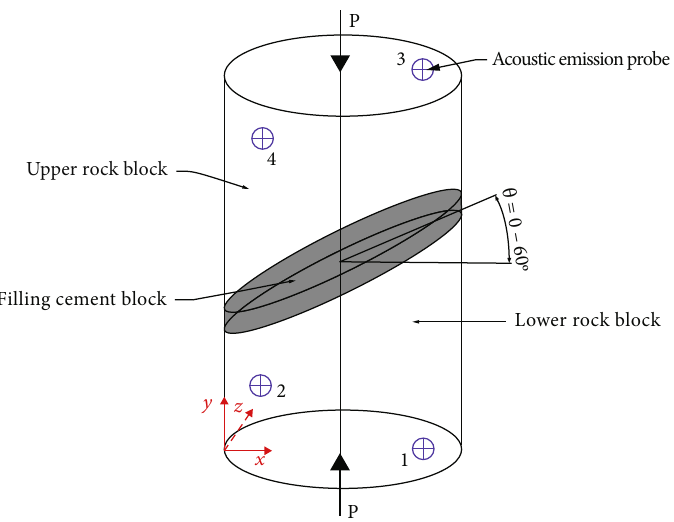
Figure 1: Schematic diagram of the fully penetrated crack grouted body.